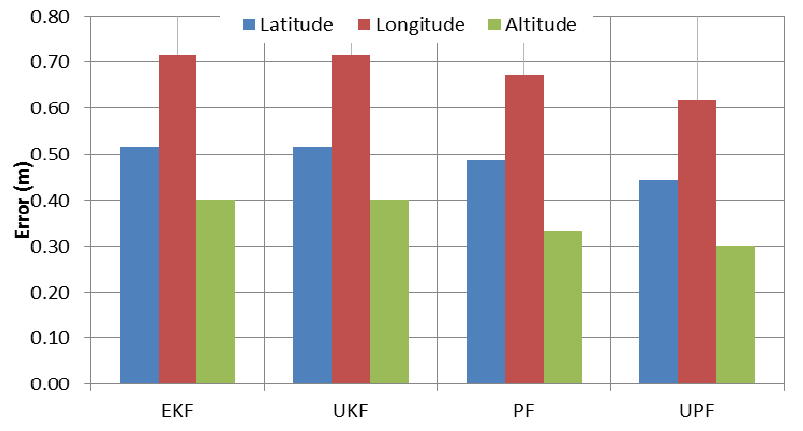
Figure 11. Average of maximum error for different estimation filters during GPS